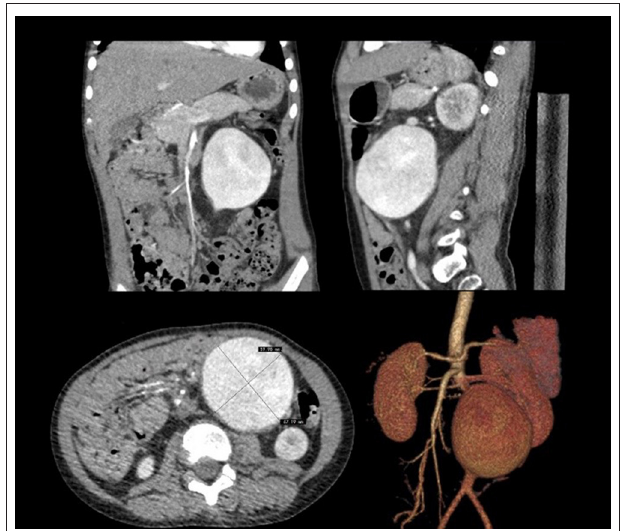
FIGURE 1 | Computerized tomography angiography demonstrated isolated infrarenal abdominal aortic aneurysm.